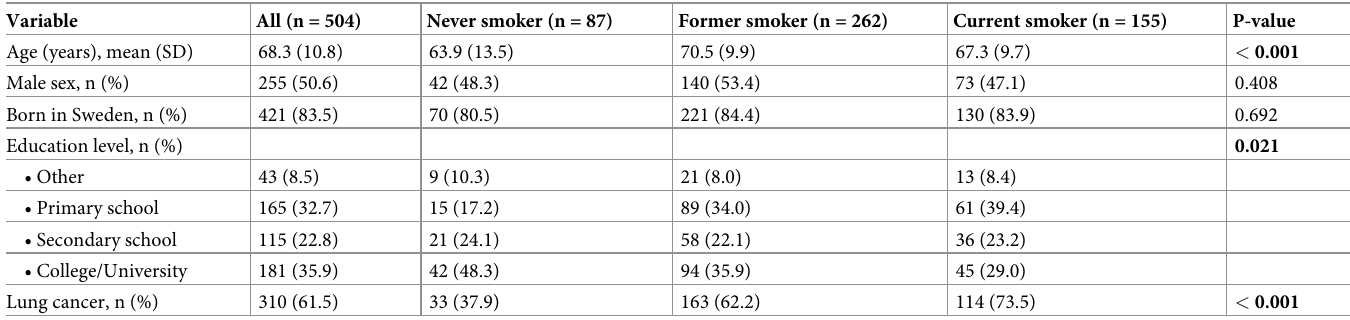
Table 1. Characteristics of the 504 participants according to smoking